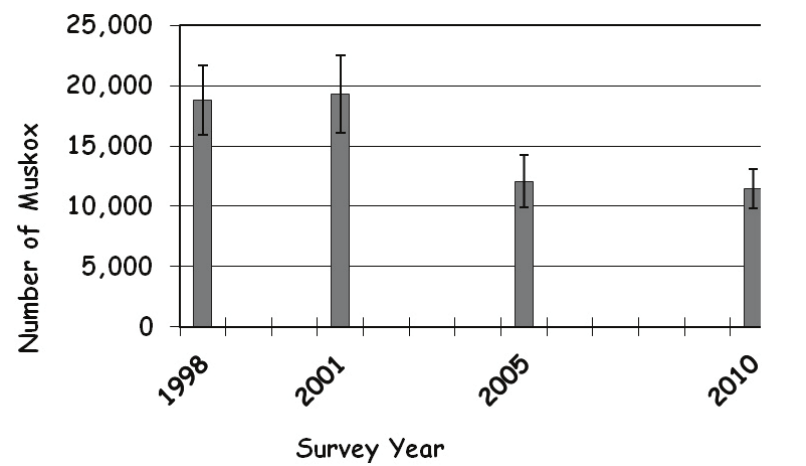
Fig. 5. Population trend of adult muskoxen on northwest Victoria Island, NWT, with 95% confidence intervals around the population